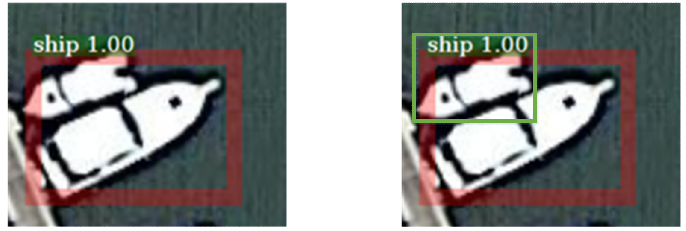
Figure 9. A common case of missed detection. The red box denotes the detected result and the green box (right) denotes the undetected object.